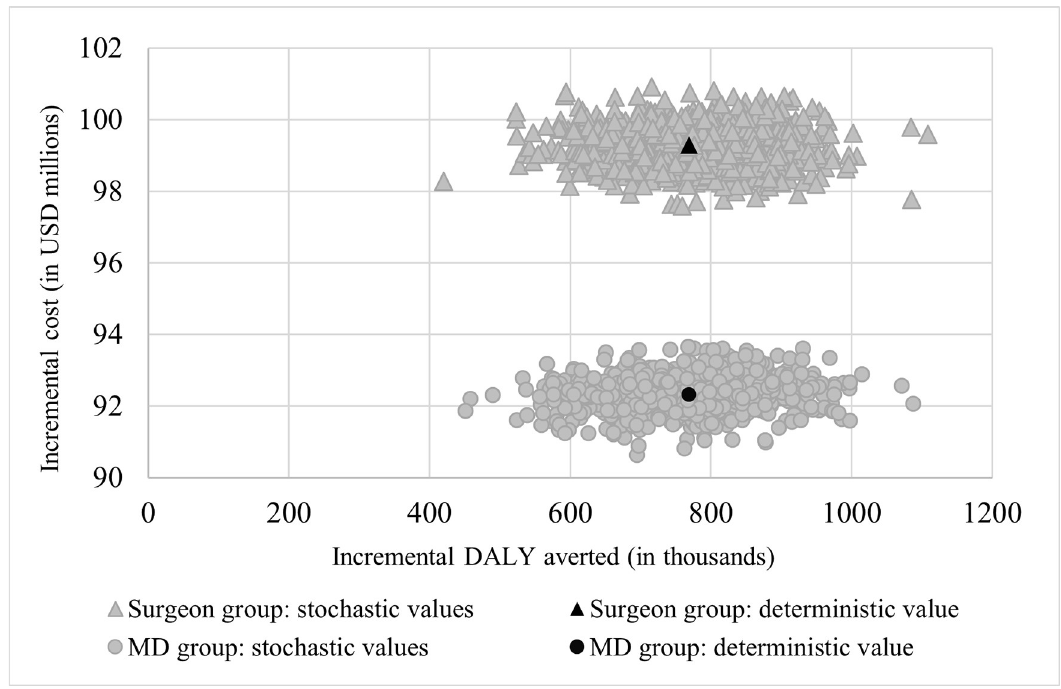
Fig 3. Stochastic sensitivity analysis of incremental cost-effectiveness ratios (ICERs). MDs medical doctors; DALY disability- adjusted life year. The scatter plot displays deterministic and stochastic values of incremental cost (in USD millions) and incremental DALYs averted (in thousands) in surgeon and MD groups from variations of inputs to the model.